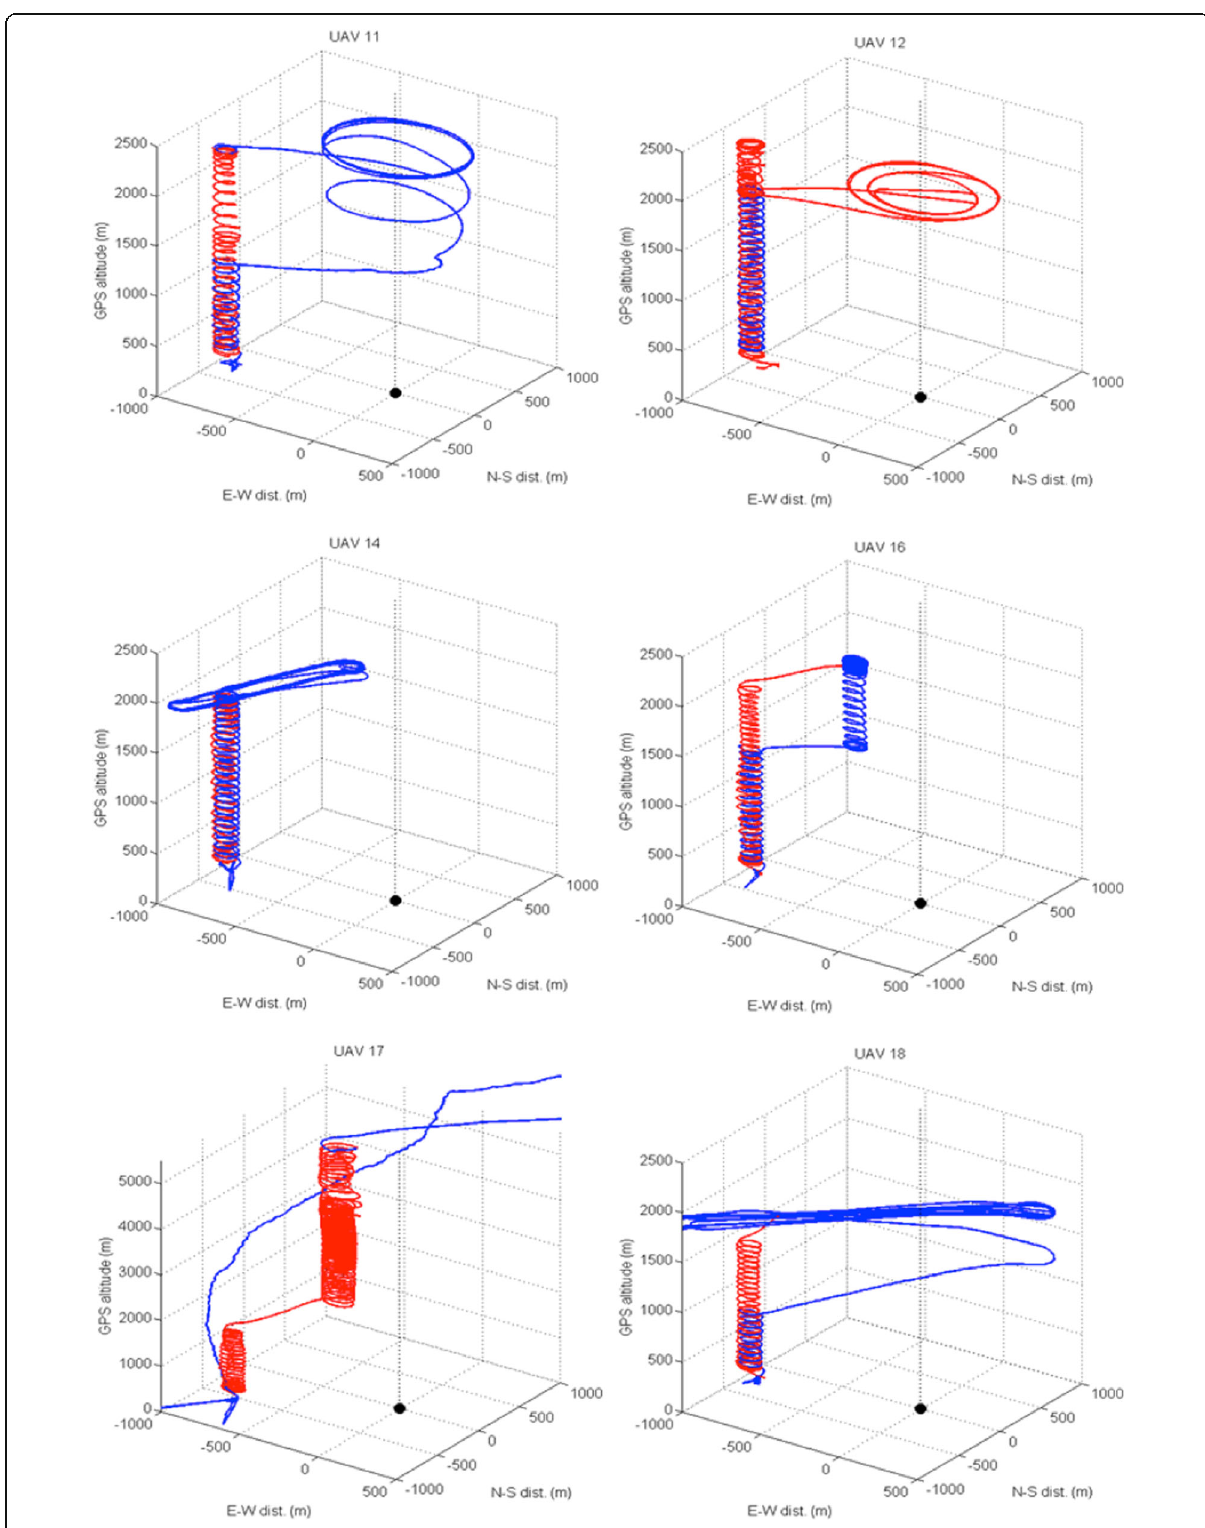
Fig. 3 Trajectories (from top left clockwise ) of UAV 11, UAV 12, UAV 16, UAV 18, UAV 17, and UAV 14. Red curves denote